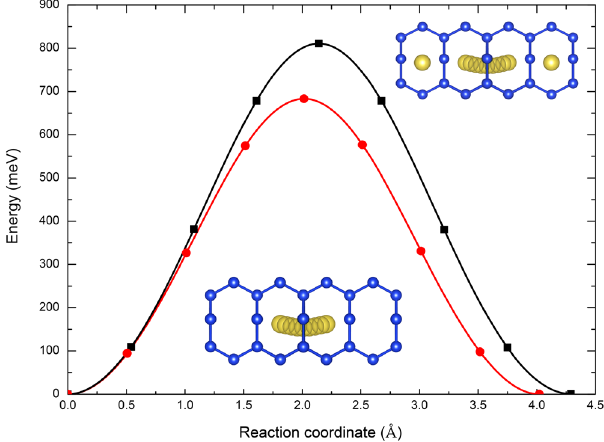
Figure 3. Migration energy profiles for sodium diffusion in Na 0.333 Si 24 (red circles) and Na 3.667 Si 24 (black squares). The lines connecting the points correspond to a spline fitted to the calculated CI-NEB energies. The insets show the atomic structures of the diffusing sodium ion along the minimum energy paths for Na 0.333 Si 24 (bottom) and Na 3.667 Si 24 (top).